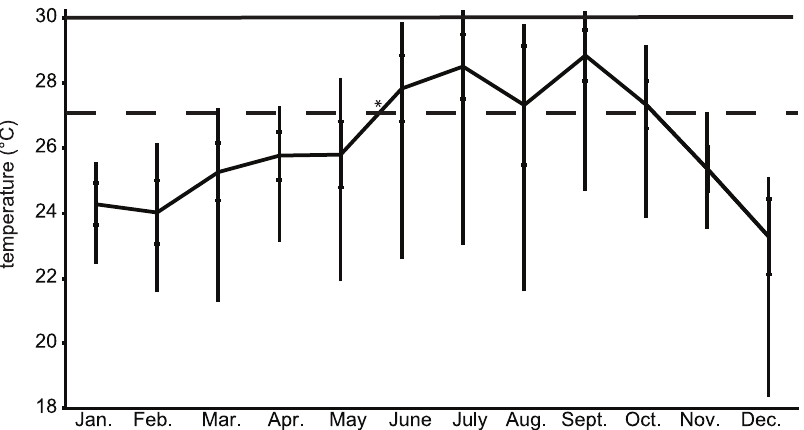
Figure 3. Temperature variation in 2009 at Houbihu, Southern Taiwan. Mean values are connected by the solid line, and error bars span the range for each month. The standard deviations are represented by internal hatches. The ‘‘*’’ denotes the approximate time at which the colonies were transplanted from Houbihu to Taiwan’s National Museum of Marine Biology and Aquarium, and the dotted line (‘‘- - -’’) reflects both the acclimation and control temperature ( , 27 u C) prior to and during experimentation, respectively. Similarly, the solid line (30 u C) reflects both the previously determined, stress-inducing temperature [27], as well as the elevated temperature used during the 48 hour experiment conducted herein.